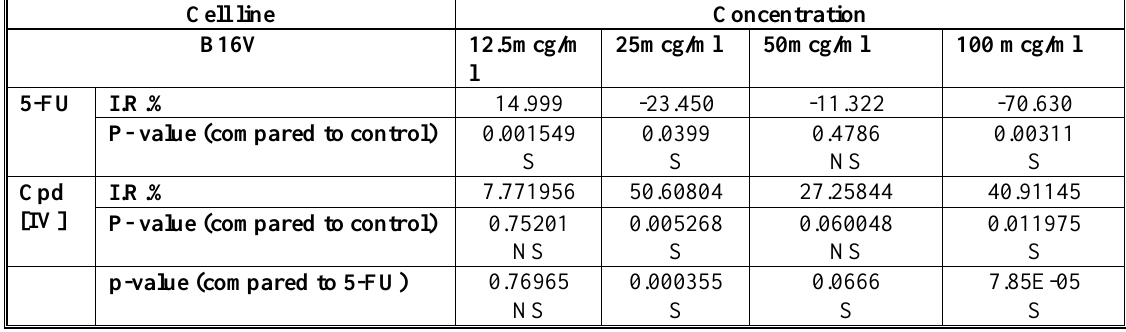
Table 2. Cytotoxic effect of 5-FU and compound [IV] on B16V cell line by crystal violet assay method